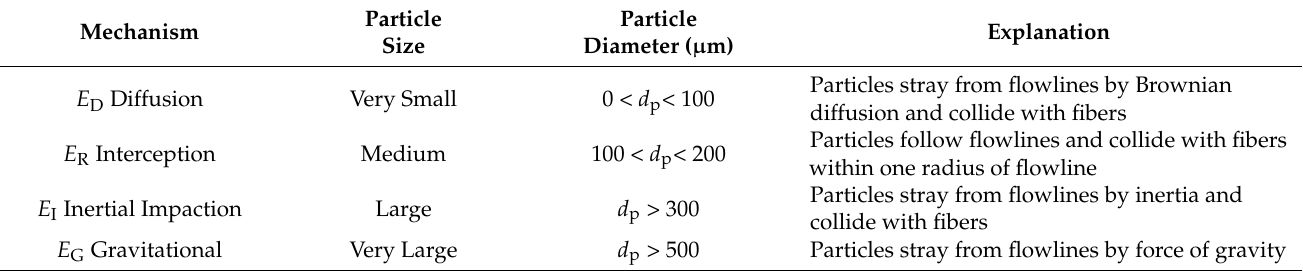
Table A2. Particle capture mechanisms based on particle size.